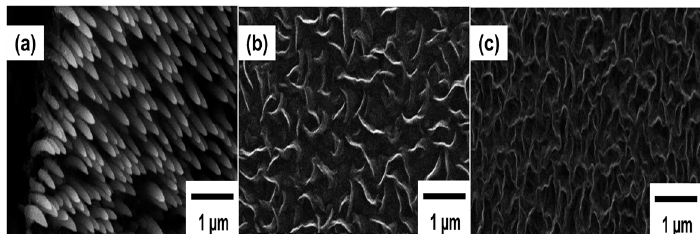
Figure 6. SEM images of ( a ) a tilted view of carbon nanofibers (CNF) and a top view of ( b ) freestanding CNW and ( c ) interconnected CNW. Reproduced with permission from [57]. Copyright Royal Society of Chemistry 2016.